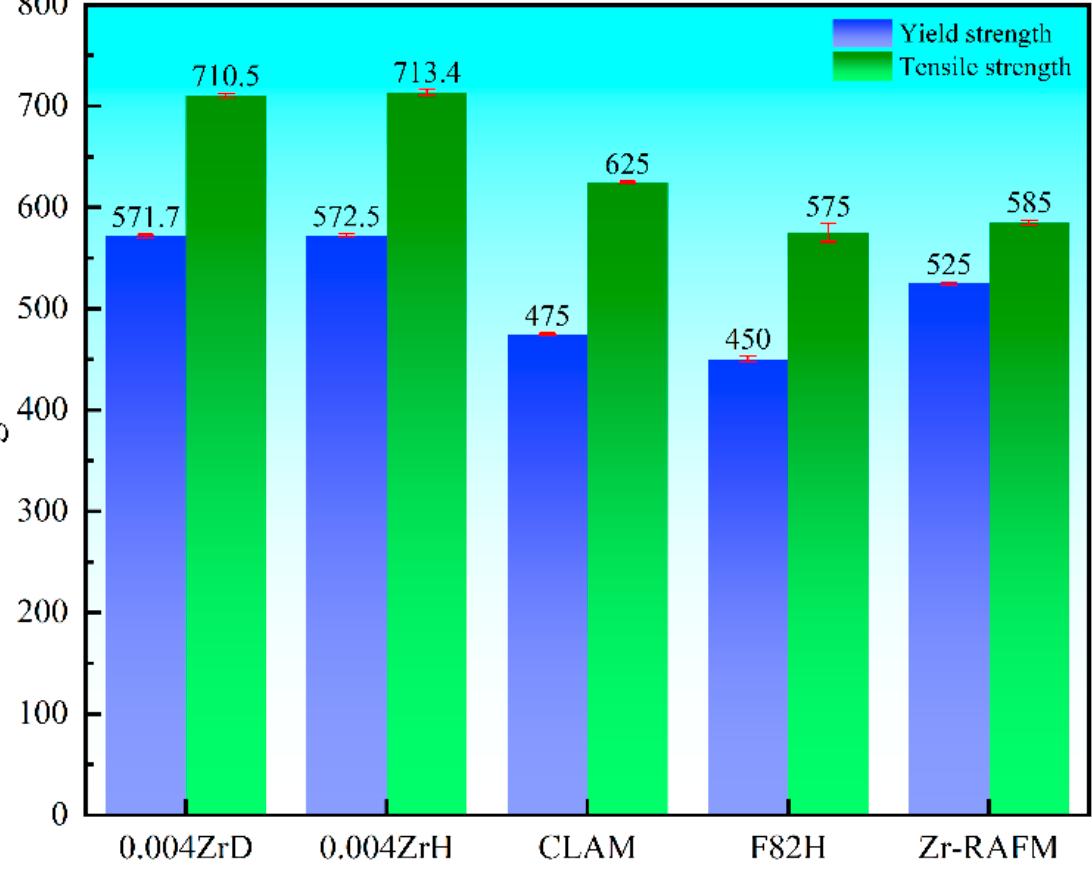
Figure 13. Mechanical properties of aged 0.004ZrD, 0.004ZrH, and other aged RAFM